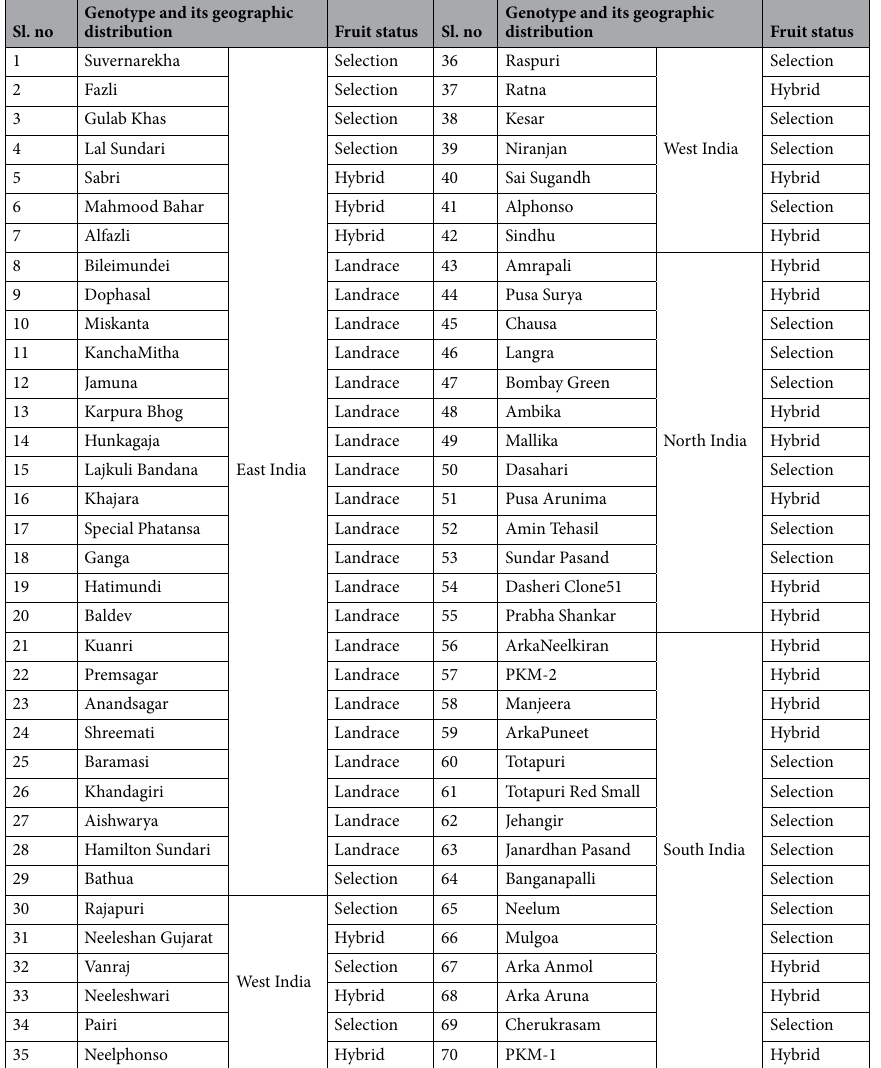
Table 1. Indian mango genotypes of 4 Geographical Populations (East India, West India, North India, South India) and 3 Fruit Status-based Populations (Selection, Hybrid, Landrace)